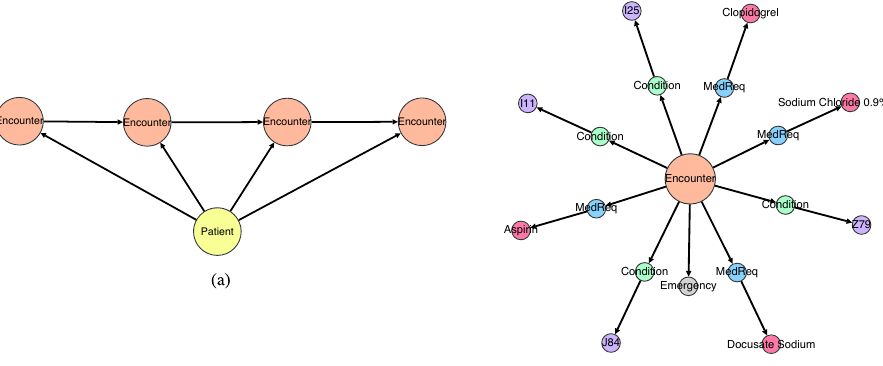
Fig. 11 The two main structures into which a patient trajectory can be decomposed. A patient trajectory can be decomposed into a patient node followed by a sequence of Encounter nodes and a set of Encounter nodes, each connected to several Condition and MedicationRequest nodes, which in turn are terminated with ConditionType and MedicationType nodes. a Example of a sequence of 4 Encounter nodes. b Example of an Encounter node.